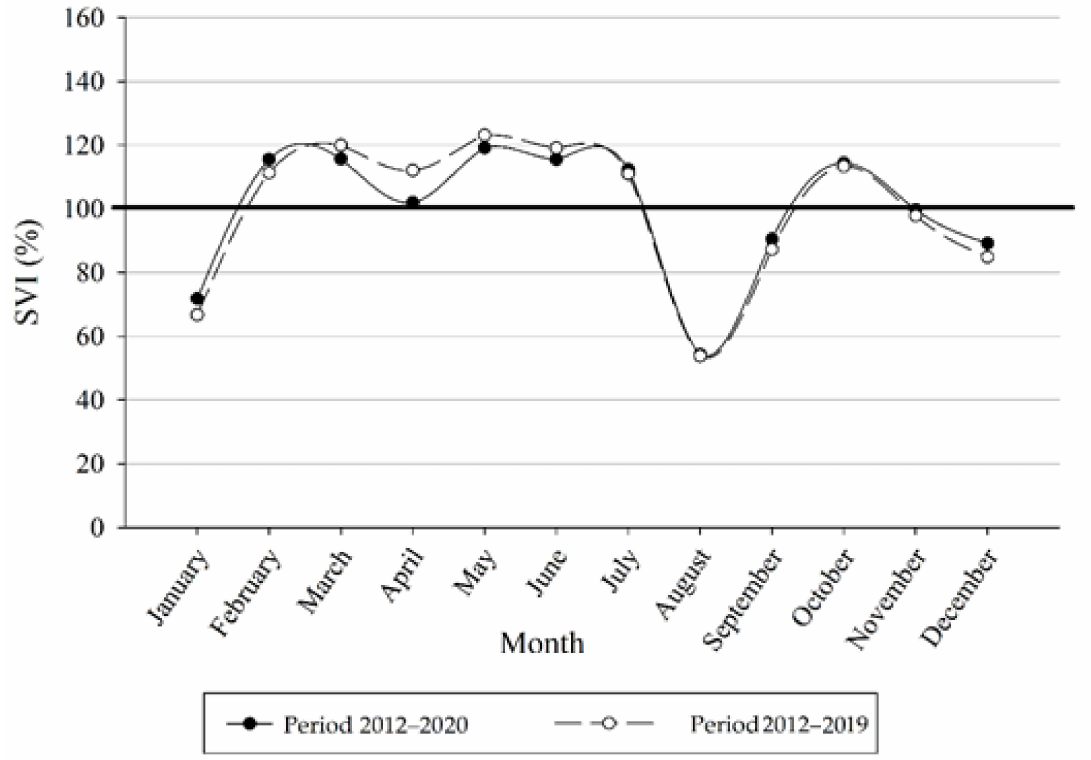
Figure 16. Seasonality pattern of vehicle embarking traffic of the port of Set ú bal during the periods 2012–2019 and 2012–2020.